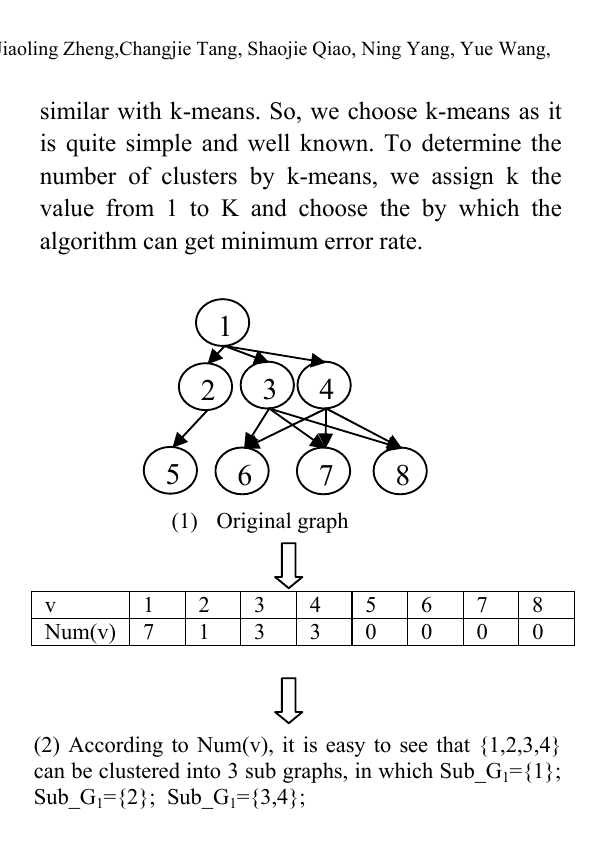
Fig. 3. Illustration of working process of algorithm